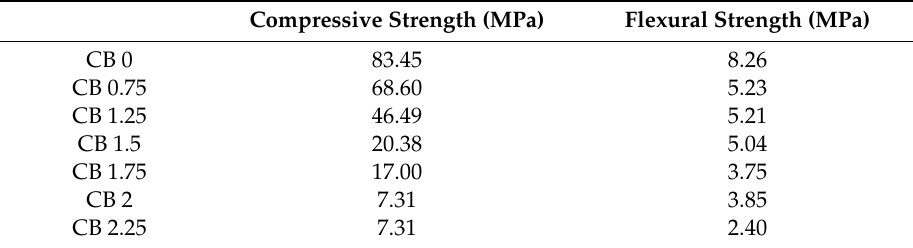
Table 3. Mechanical properties of the studied geopolymers.